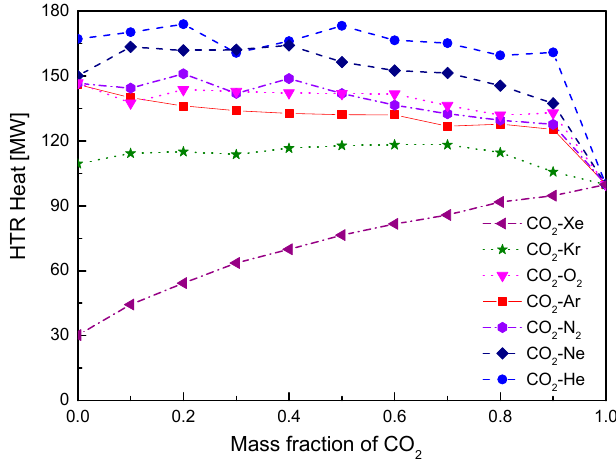
Figure 12. High-temperature recuperator (HTR) heat of mixtures at different mass fractions of CO 2 .